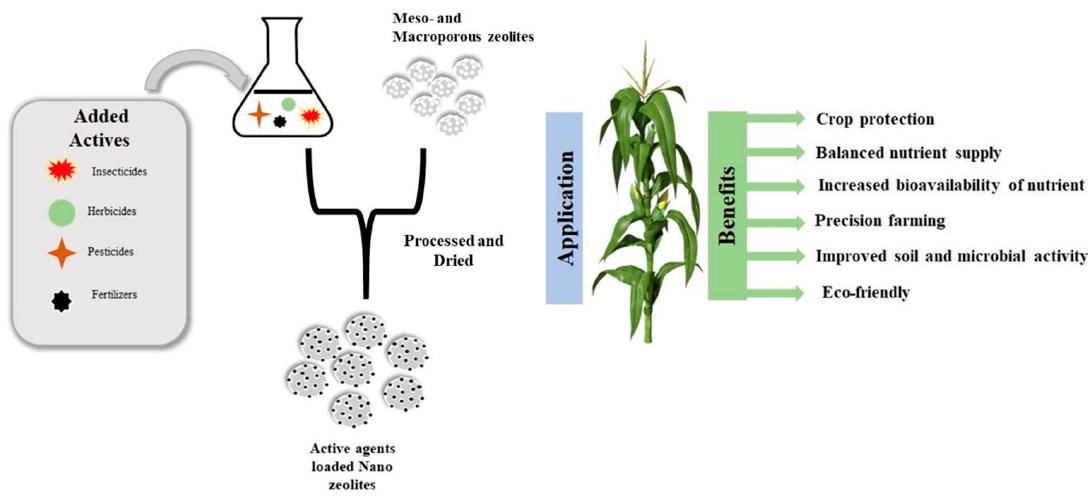
Figure 7. Nano-zeolites as carriers for the slow and targeted release of compounds.